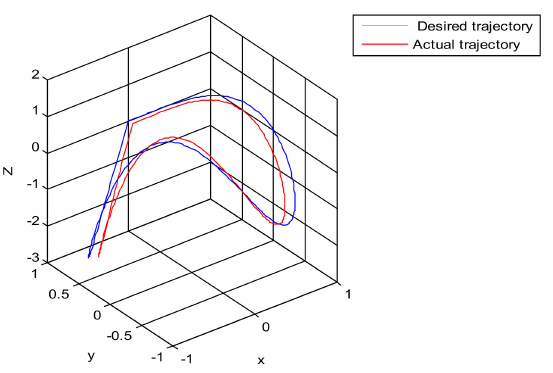
Figure 11. The trajectory tracking of end effector of Baxter right arm (sliding mode